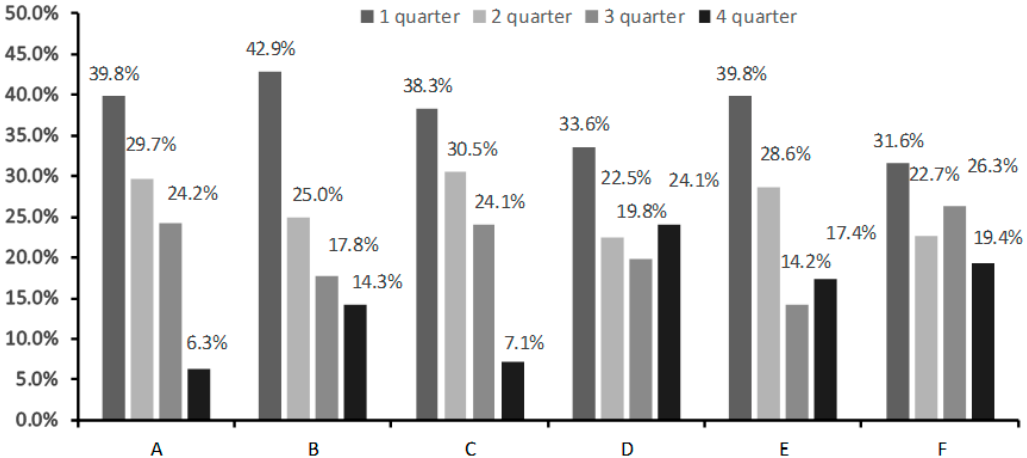
Figure 4. The prevalence of RAE in junior and youth Russia national football teams ( A ), in the leading clubs of the Russian Premier League ( B ), in youth teams of leading non-English clubs participating in the Union of European Football Associations (UEFA) Youth League championships ( C ), in youth teams of leading English clubs participating in the UEFA Youth League championships of 2018–2019 ( D ), in the leading Russian adult football teams ( E ), and in the top 11 countries according to International Federation of Association Football (FIFA) rating as of April 6, 2019, as well as the Germany national team (2014 World champion) and the Russia national team (World championship host) ( F ).